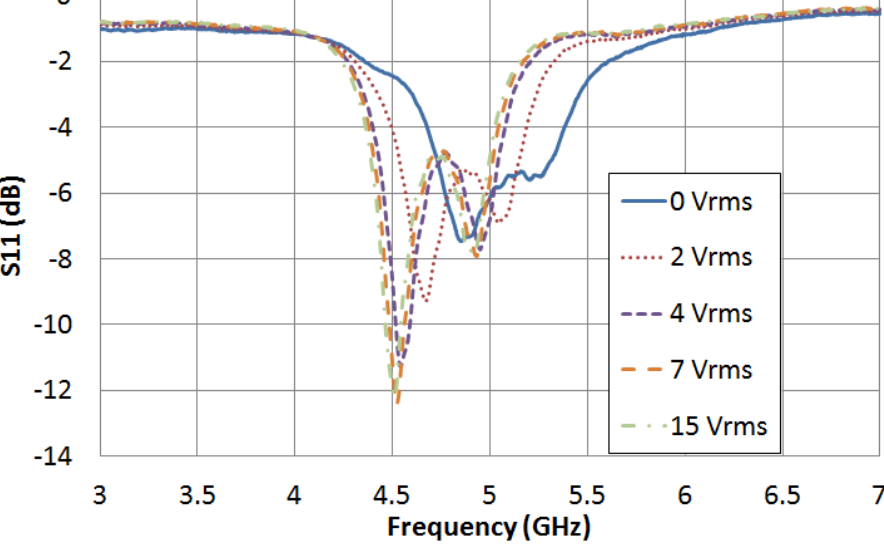
Figure 6. LC driving voltage dependence of the S